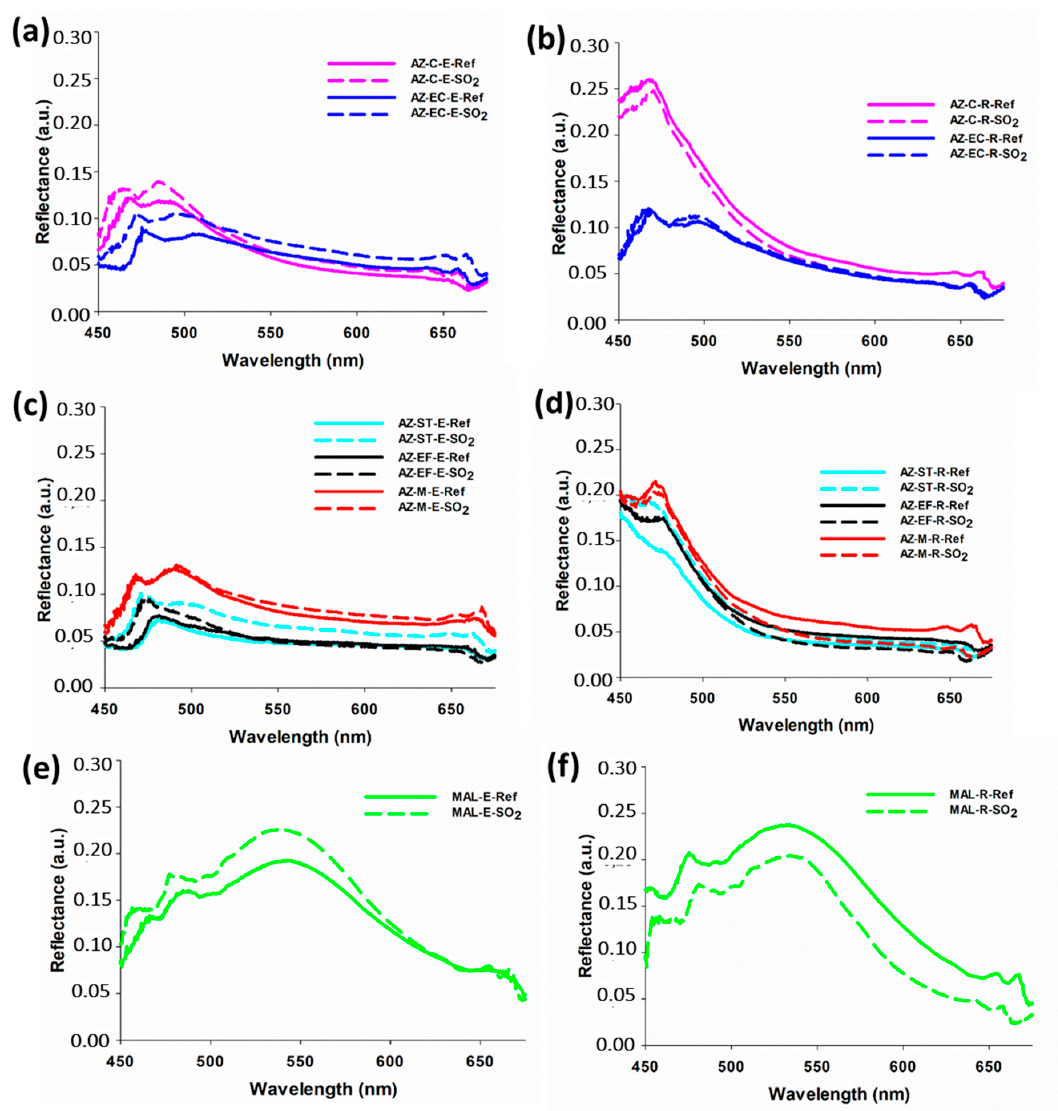
Figure 4. Reflectance spectra of fresh (Ref in solid line) and aged (SO 2 in dashed line) paint mock-ups with egg yolk–E-( a , c , e ) and rabbit glue–R-( b , d , f ). See Table 1 for paint labeling. (For interpretation of